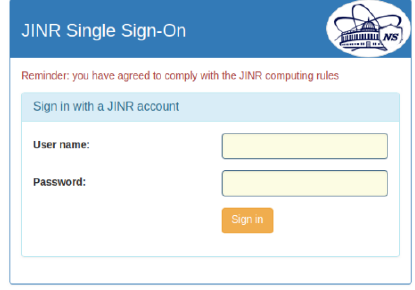
Fig. 2. A screenshot of the JINR SSO login